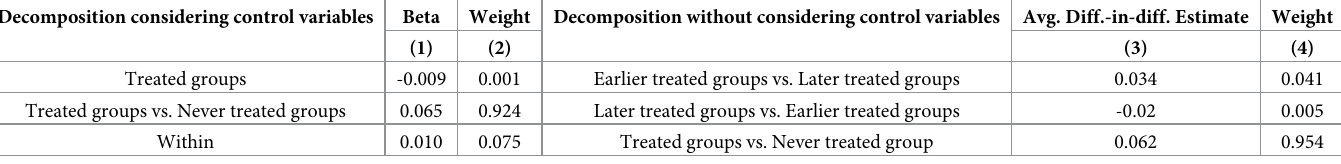
Table 4. Bacon decomposition